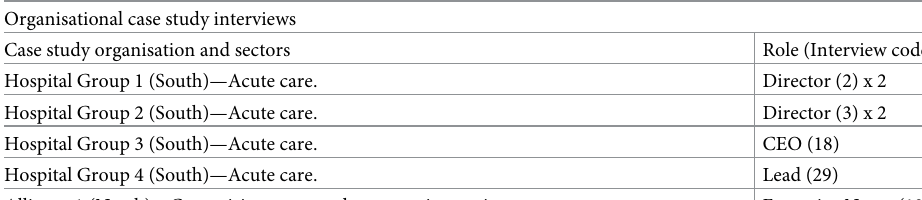
Table 1. Participant and interview/focus group characteristics and case